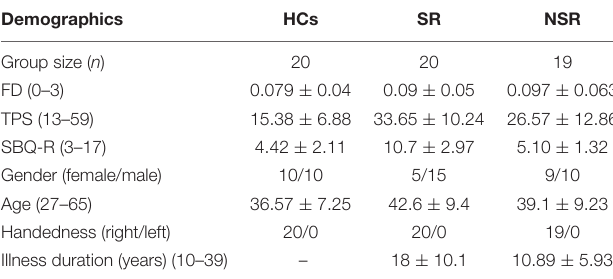
TABLE 1 | Detailed participant demographic and clinical information.